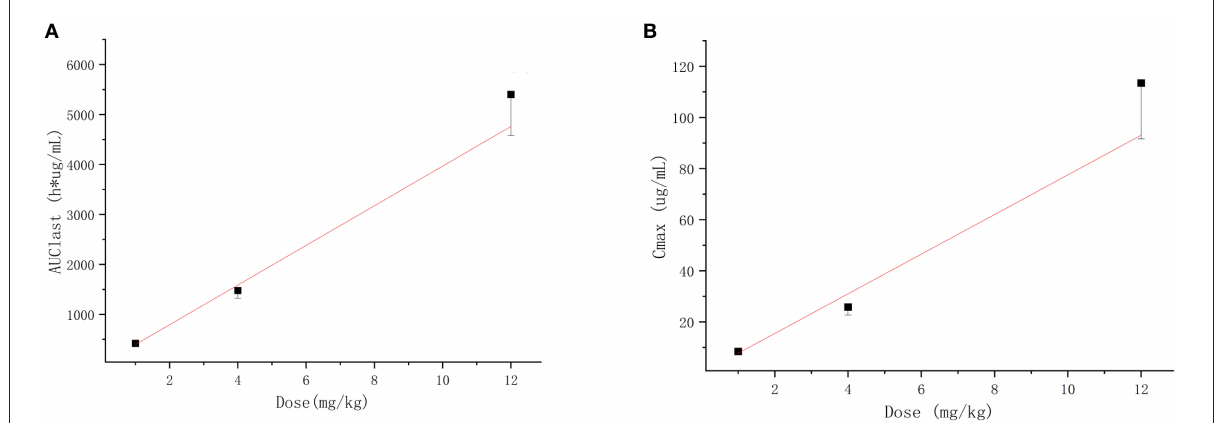
FIGURE6 Dose-proportionality assessment of recombinant canine PD-1 fusion protein pharmacokinetics in healthy canine. (A) Mean ± SD for AUClast vs dose for subjects in each cohort with the linear regression line defined by f ( x ) = 396.833x, r 2 = 0.993. (B) Mean ± SD for C max vs. dose for subjects in each cohort with the linear regression line defined by f ( x ) = 7.755x, r 2 = 0.982.